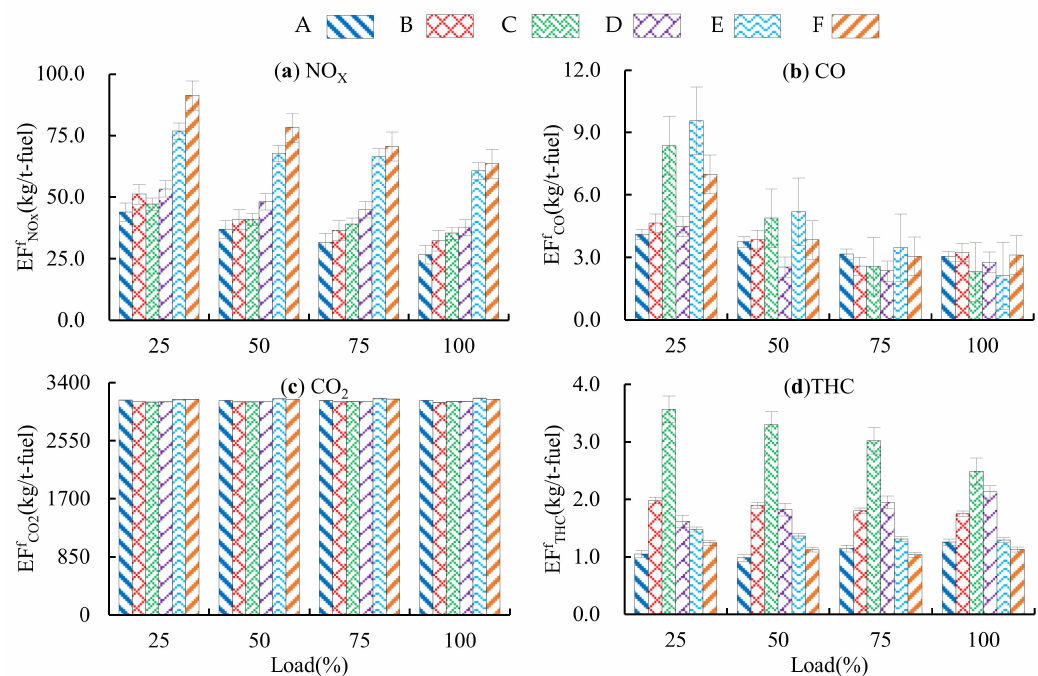
Figure 2. Relationship of fuel-based emission factors against engine load for ME. Fuel-based emission factors at four load points for the main engine. ( a ) NO X fuel-based emission factors, ( b ) CO fuel-based emission factors, ( c ) CO 2 fuel-based emission factors, and ( d ) THC fuel-based emission factors. The relationship between diesel engine power and speed is cubic equation.